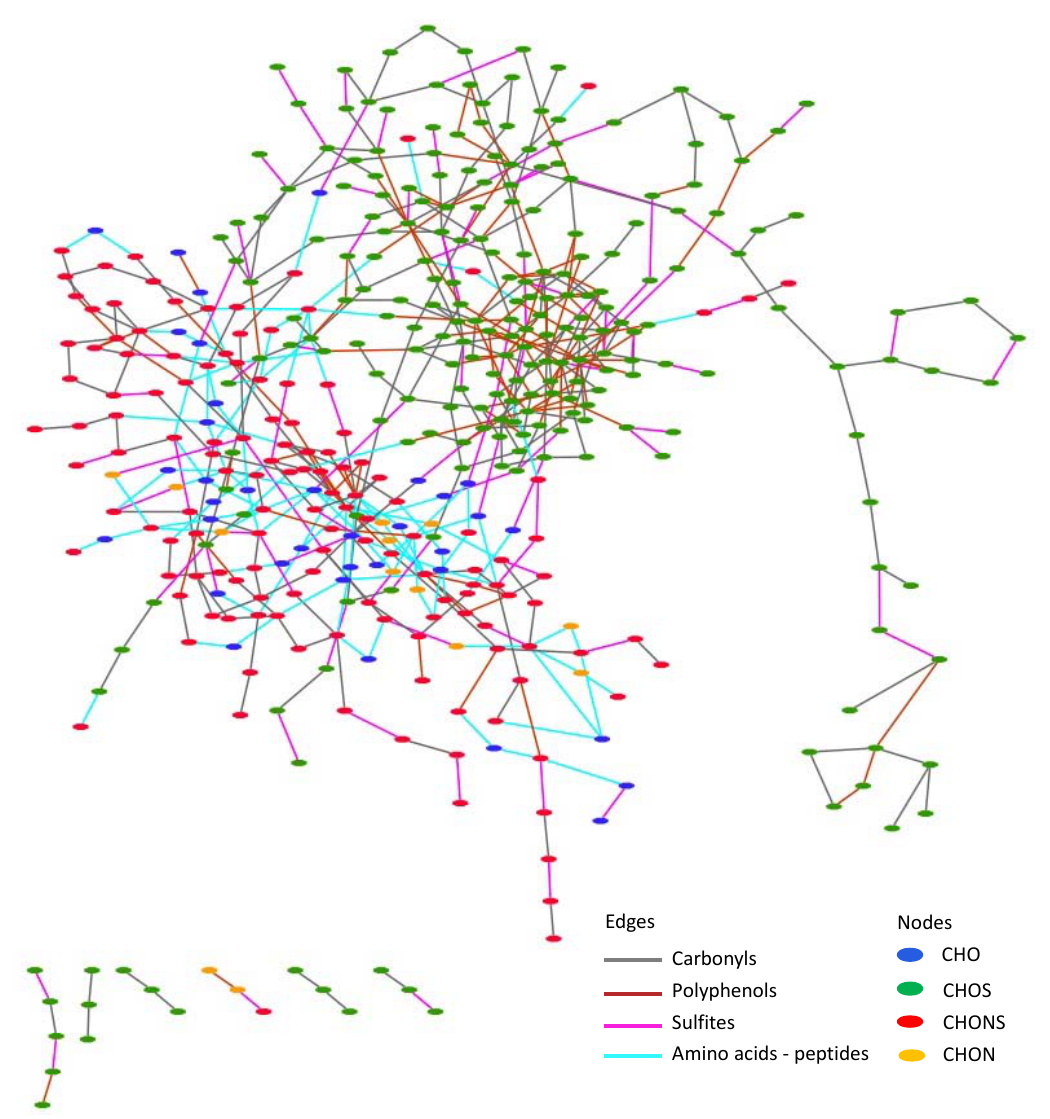
Figure 4. Full compositional network built from the CHONS chemical space of G wines, with nodes colored according to molecular classes, i.e., CHO (blue), CHOS (green), CHONS (red), and CHON (orange), and edges colored according to mass differences specific to nucleophilic addition reactions of known phenolic, sulfites (HSO 3 − ), carbonyls, and amino acids—peptide compounds with unknowns in G-related molecular